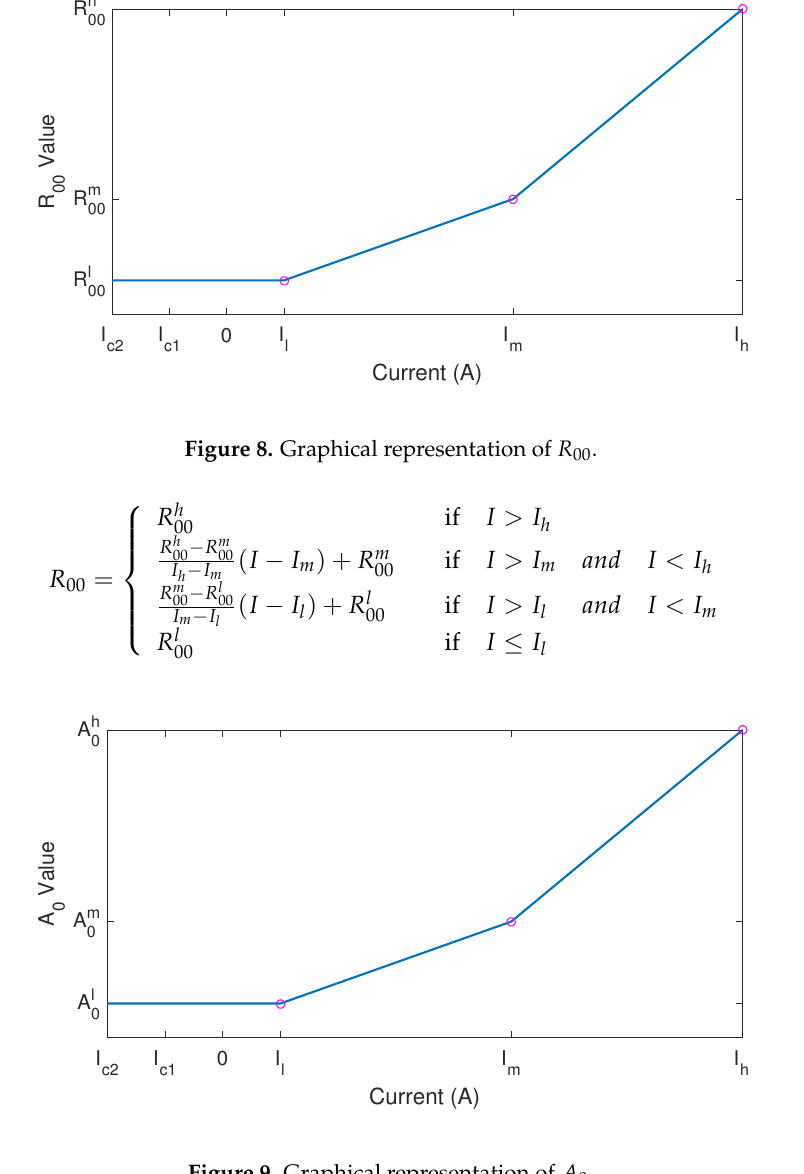
Figure 9. Graphical representation of A 0